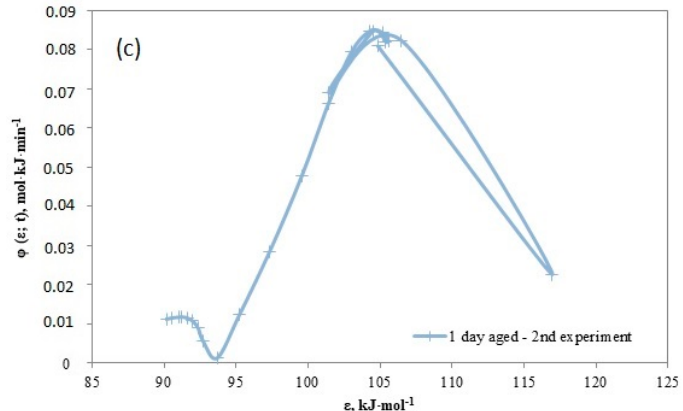
Figure 9. The energy distribution function ϕ ( ε ; t ) versus the local adsorption energy, ε , at the temperature of the maximum catalytic activity (80 °C) for the adsorption of hydrogen on Ni nanocatalysts (sample 27): ( a ) fresh catalyst, ( b ) 1 day aged catalyst ( first experiment), and ( c ) 1 day aged catalyst (second experiment).